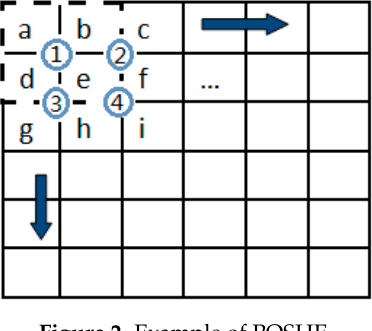
Figure 2. Example of POSHE.